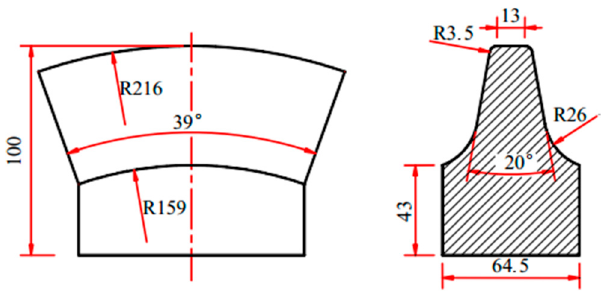
Figure 2. Dimensions and cross section of tunnel boring machine (TBM) disc cutters (mm).